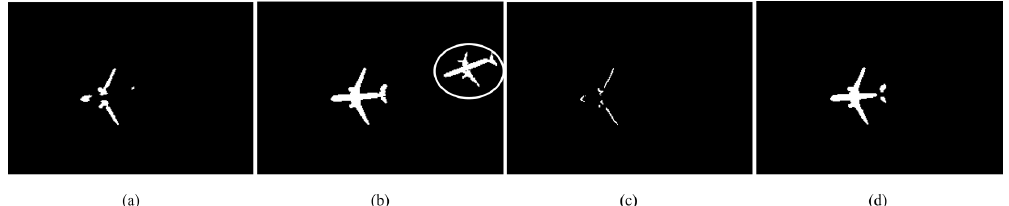
Figure 2. Moving airplane detection with a background model of different adaption strategies: ( a ) both the foreground and background are adapted with the same learning rate; ( b ) only the background is adapted; ( c ) the foreground is adapted with a smaller learning rate than the background; and ( d ) the detection in ( c ) is further boosted by a morphological closing operation.